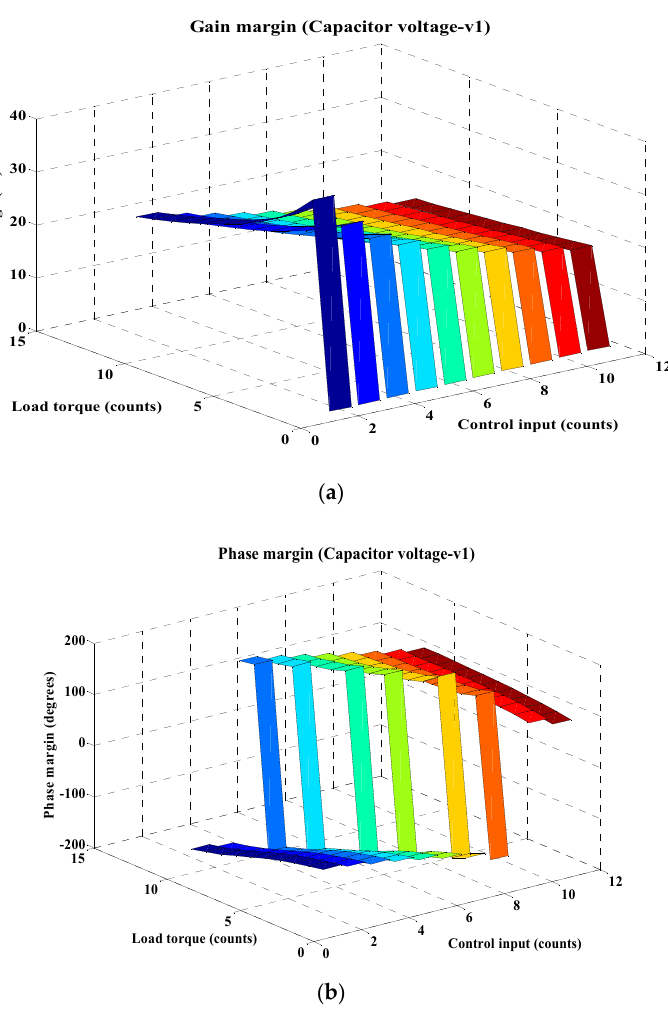
Figure 12. Frequency response of capacitor voltage (v 1 ). ( a ) Gain margin; ( b ) Phase margin.